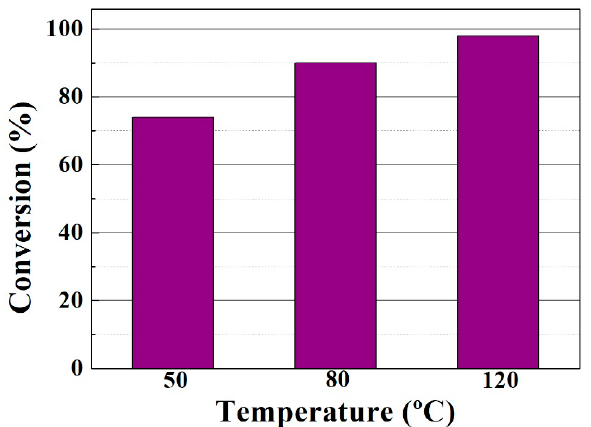
Figure 7. Influence of the reaction temperature on the FACO to esters conversion in the esterification of FACO with EH. Catalytic conditions: EH:FACO molar ratio of 1.5, reaction time: 6 h, catalyst/FACO ratio: 6 g/100 g.